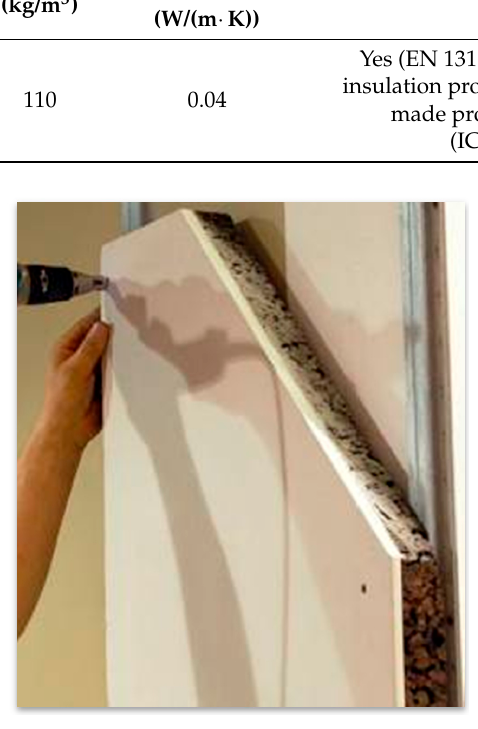
Figure 2. ICB glued to gypsum plasterboard in an Internal TICS (ITICS) [10]. Table 1. Main technical characteristics of ICB studied in this paper.